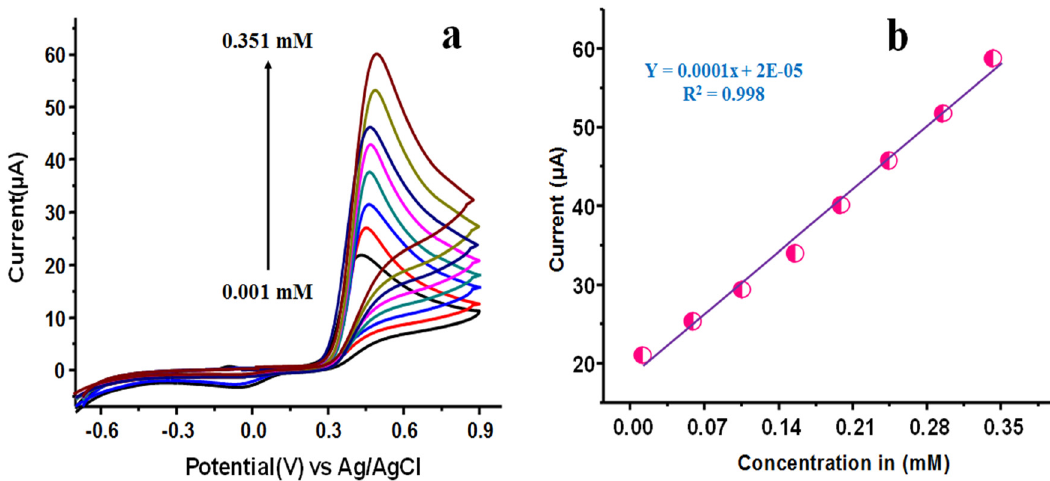
Figure 6: ( a ) Calibration plot ( peak current response vs UA concentration ) ranges from 0.001 to 351 mM and ( b ) shows the linear response of peak current with R 2 = 0.998 at scan rate 50 mV/s.